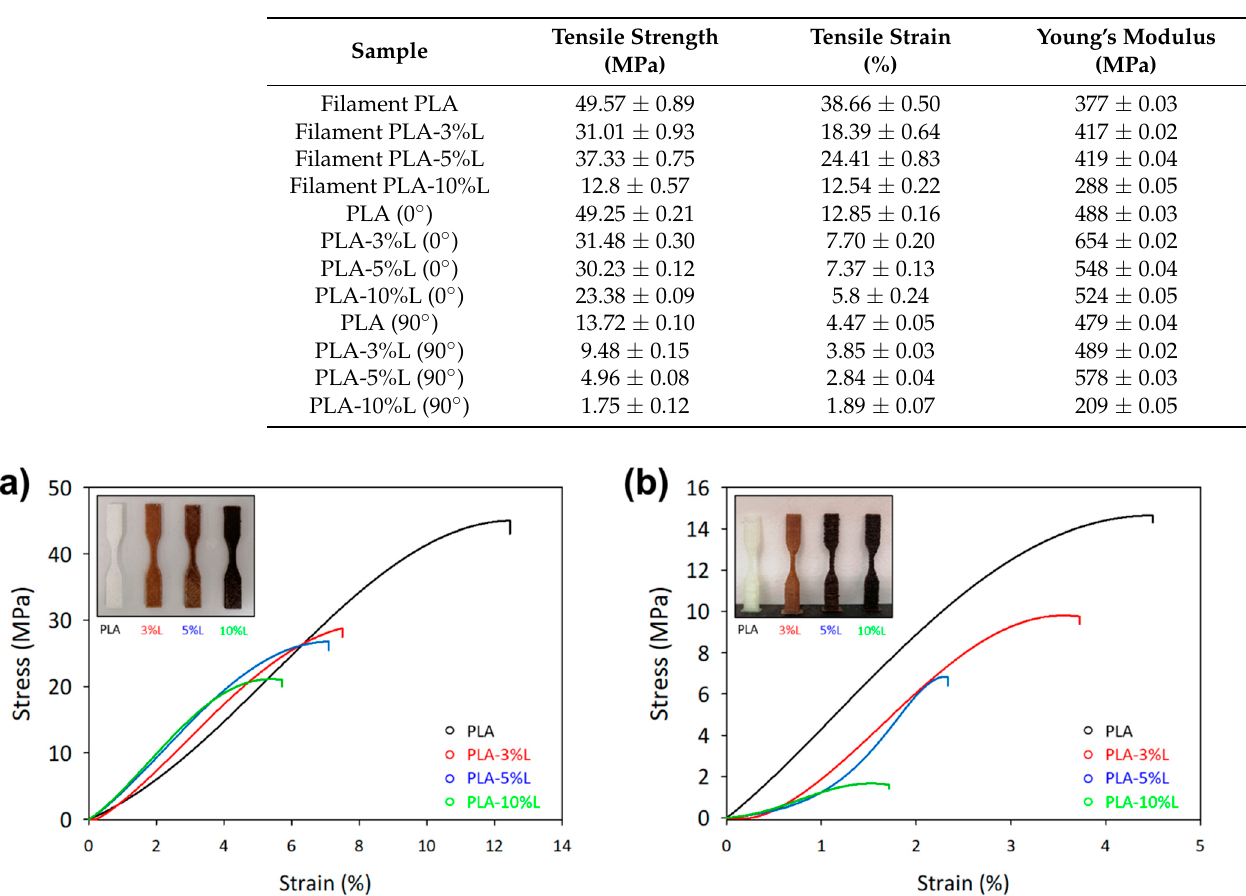
Table 2. Mechanical properties of extruded filaments and 3D printed PLA and PLA incorporated with lignin at different horizontal (0 ◦ ) and vertical (90 ◦ ) orientations.